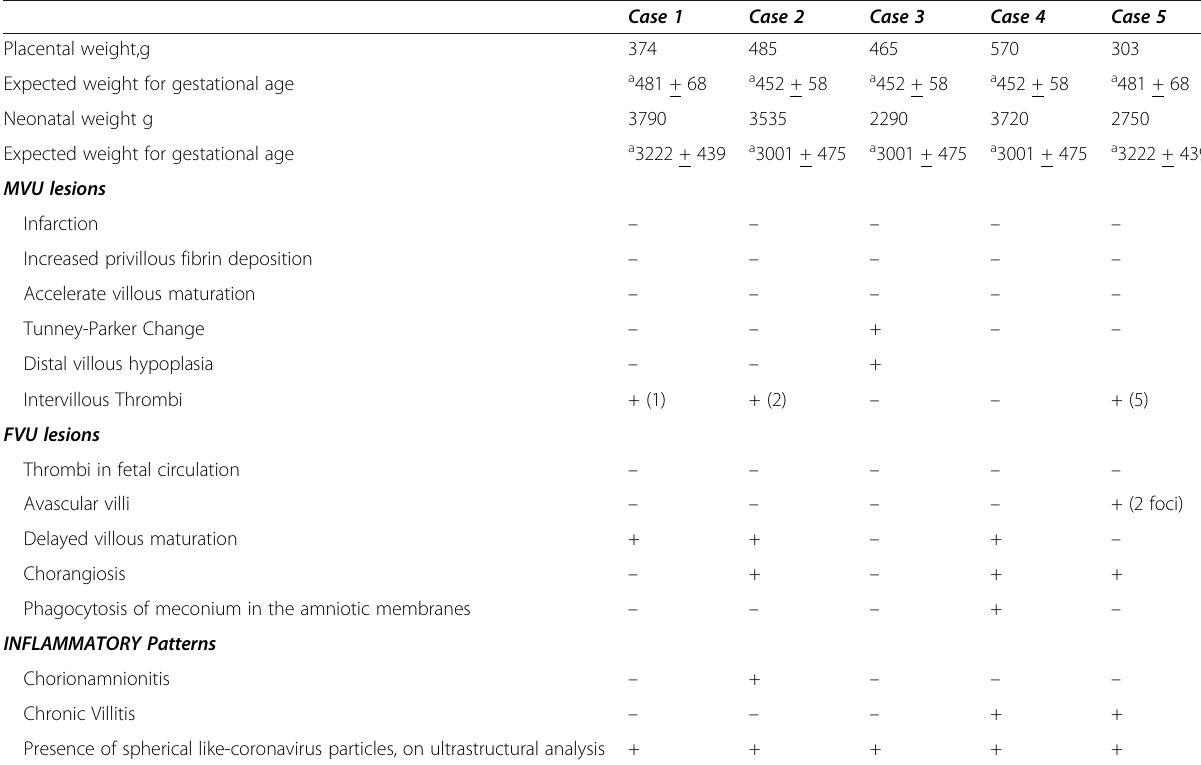
Table 3 Pathological placental patterns